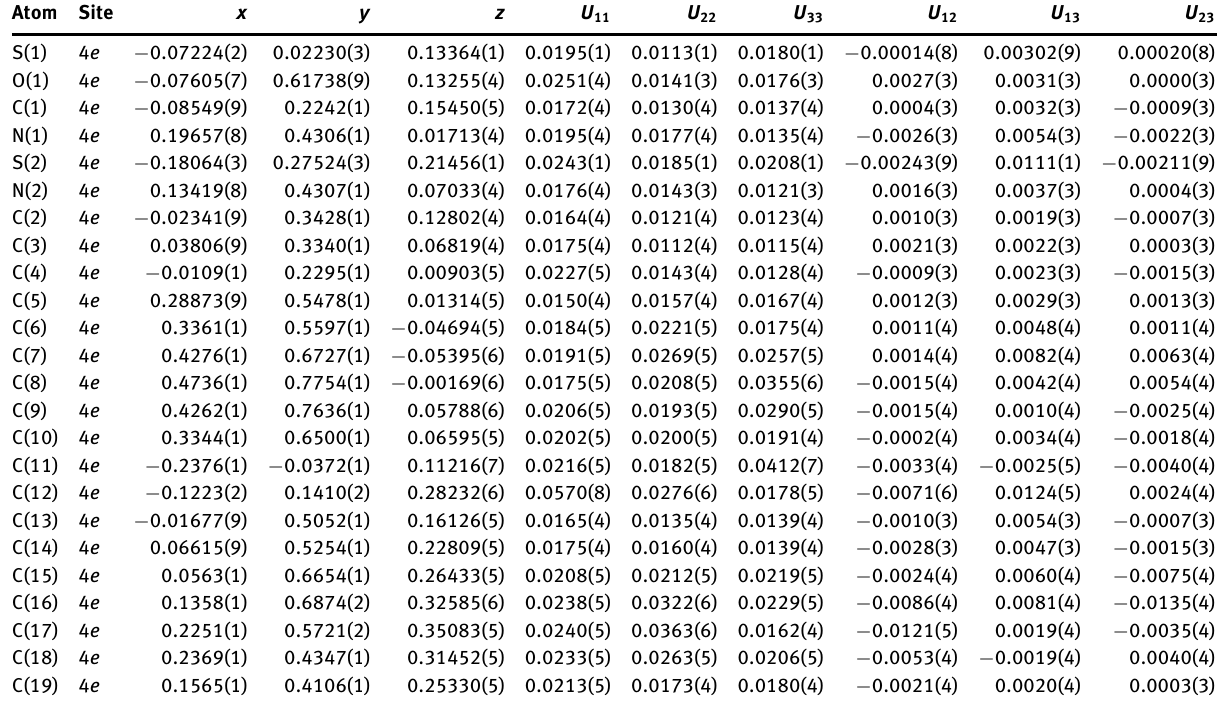
Table 3: Atomic displacement parameters (Å 2